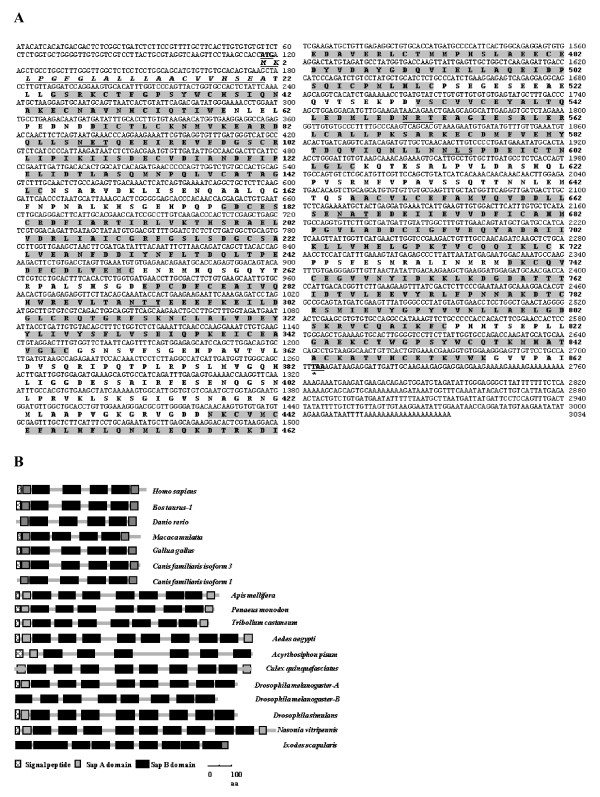
Analysis of Penaeus monodon Saposin (PmSap). (A) The full-length cDNA and deduced protein sequence of PmSap (3034 bp; ORF 2589 bp, 862 aa) of P. monodon. Start (ATG) and stop (TAA) codons are illustrated in boldface and underlined. The signal peptide of the deduced PmSap protein is italicized and underlined. Putative N-linked glycosylation sites are underlined. Two domains of Saposin A (positions 25-58 and 823-856) and seven domains Saposin B (positions 68-144, 178-251, 272-346, 437-512, 531-606, 646-721, and 738-813 of the deduced protein) are highlighted. (B) Diagram showing SapA and SapB domains in prosaposin in various vertebrates; Homo sapiens (CAI40836), Bos taurus (NP_776586), Macaca mulatta (XP_001106592), Canis familiaris (XP_536382 and XP_861441), Gallus gallus (NP_990142), Danio rerio (AAH63994) and saposin-related protein in invertebrates; Acyrthosiphon pisum (XP_001943244), Apis mellifera (XP_392338), Tribolium castaneum (XP_966852), Aedes aegypti (XP_001662994), Culex quinquefasciatus (XP_001864689), Drosophila melanogaster (NP_524597 and NP_733408), Drosophila simulans (XP_002105562), Nasonia vitripennis (XP_001603446) and Ixodes scapularis (XP_002412058). Sequenced were retrieved from the GenBank and compared with saposin-related protein of P. monodon. Four SapB domains are conserved in vertebrate saposins whereas the number of SapB domains varies among invertebrate taxa.